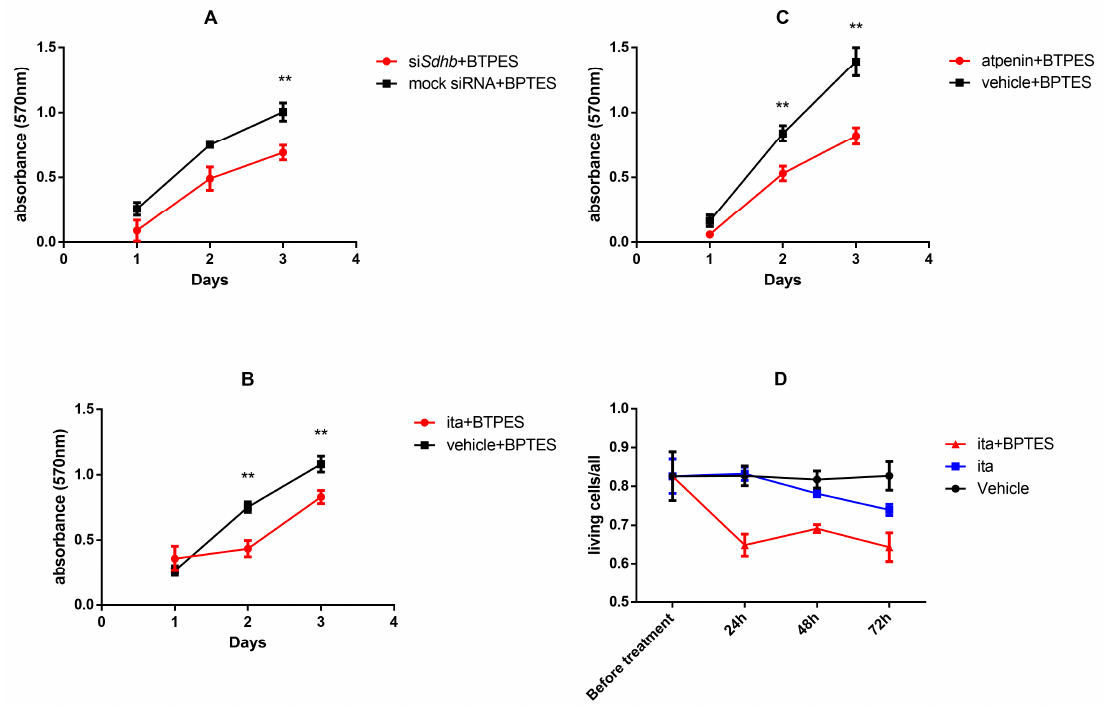
Figure 8. Proliferation of SDH impaired PC12 cells upon BPTES treatment. Cell proliferation was assessed by SRB assay. ( A – C ) Effects of SDH impairment and BPTES treatment on cell proliferation of PC12 cells cultured in monolayer. Experiments were performed in hexuplicates. ( D ) The effects of itaconate and BPTES treatment in PC12 spheroid cell culture. The ratio of living cells to total number of cells is shown before treatment and after 24, 48, and 72 h incubation. All experiments were performed at least six times in each group. Values are shown as mean ± standard error mean. SRB: Sulforhodamine B; BPTES: bis-2-(5-